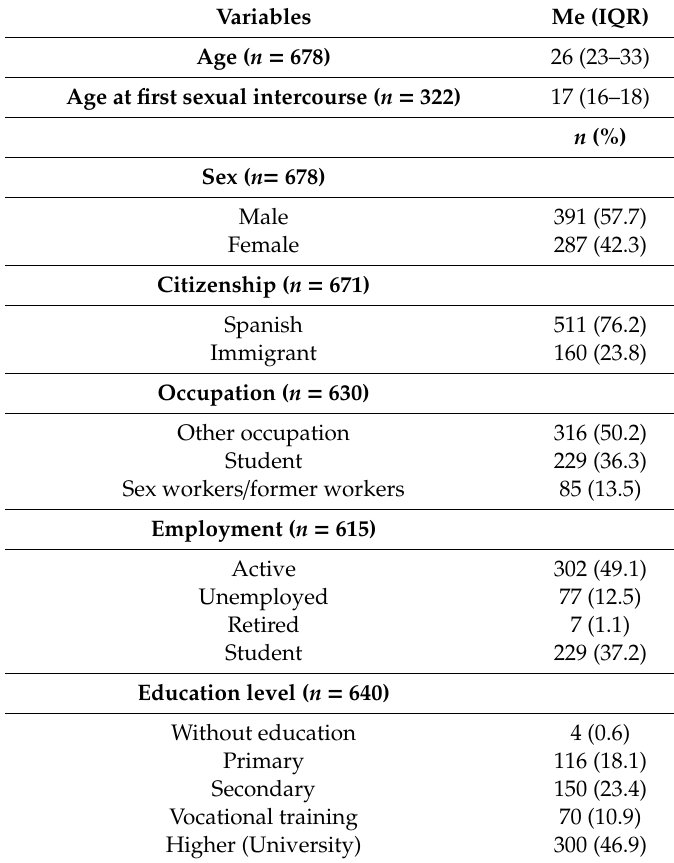
Table 1. Sociodemographic features, medical care and risk